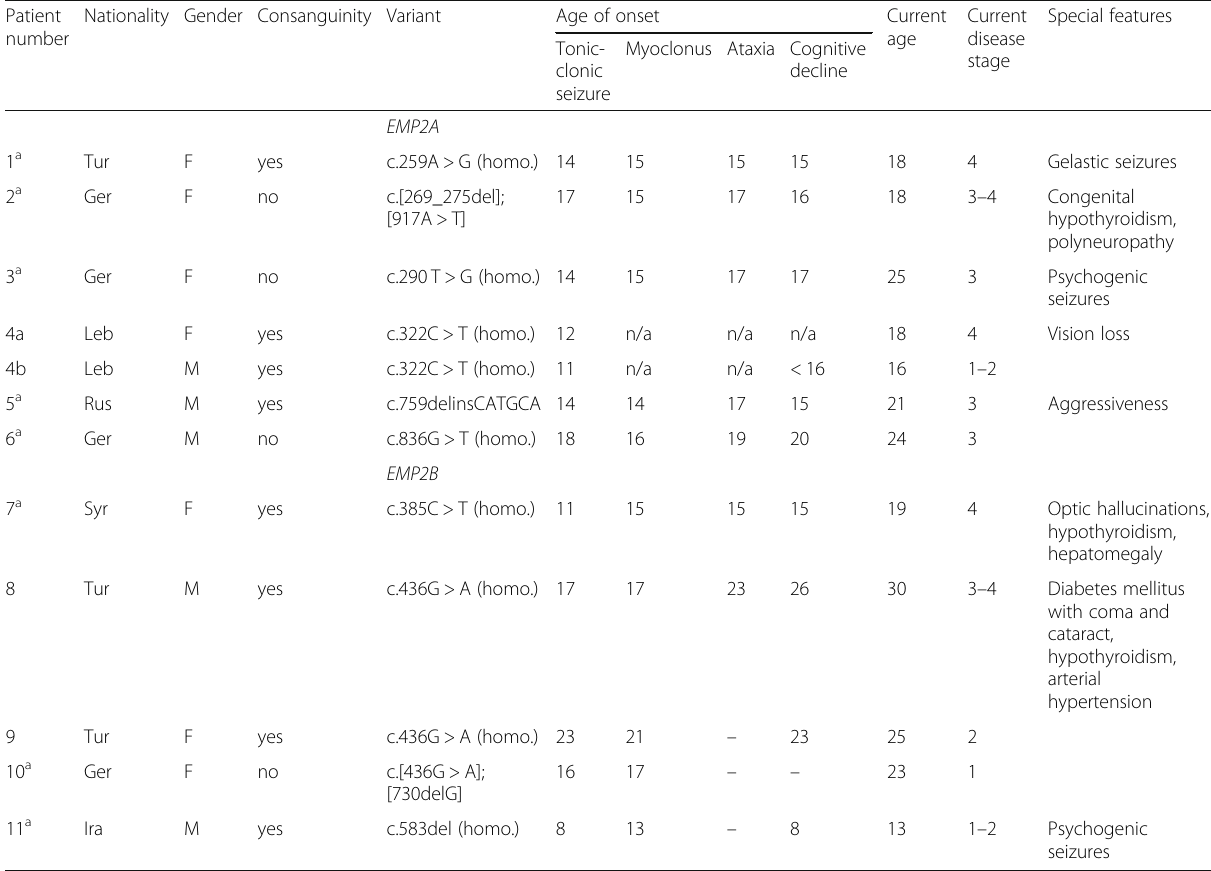
Table 2 Disease courses of LD patients living in Germany Patient Nationality Gender Consanguinity number